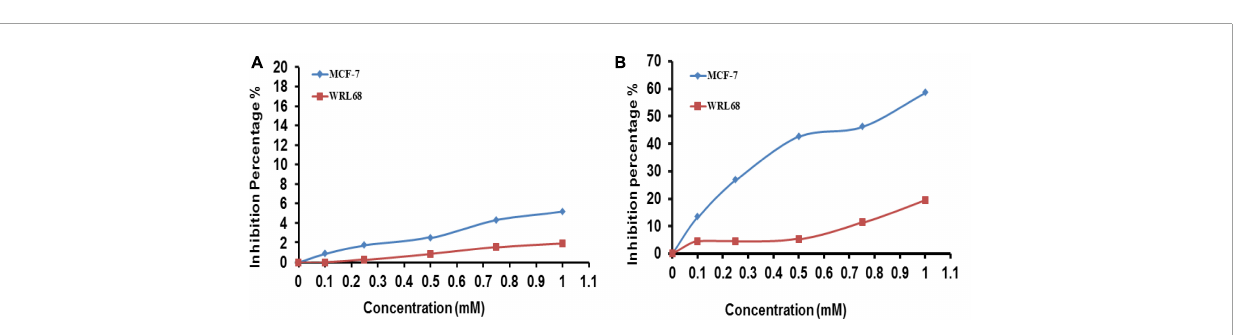
FIGURE8 Viability of WRL68 and MCF-7 breast cancer cell lines, cells treated with different concentrations of panel (A) F. ananassa extract; (B) FA-AgNPs. Numerical data are reported as the mean ± SD ( n =